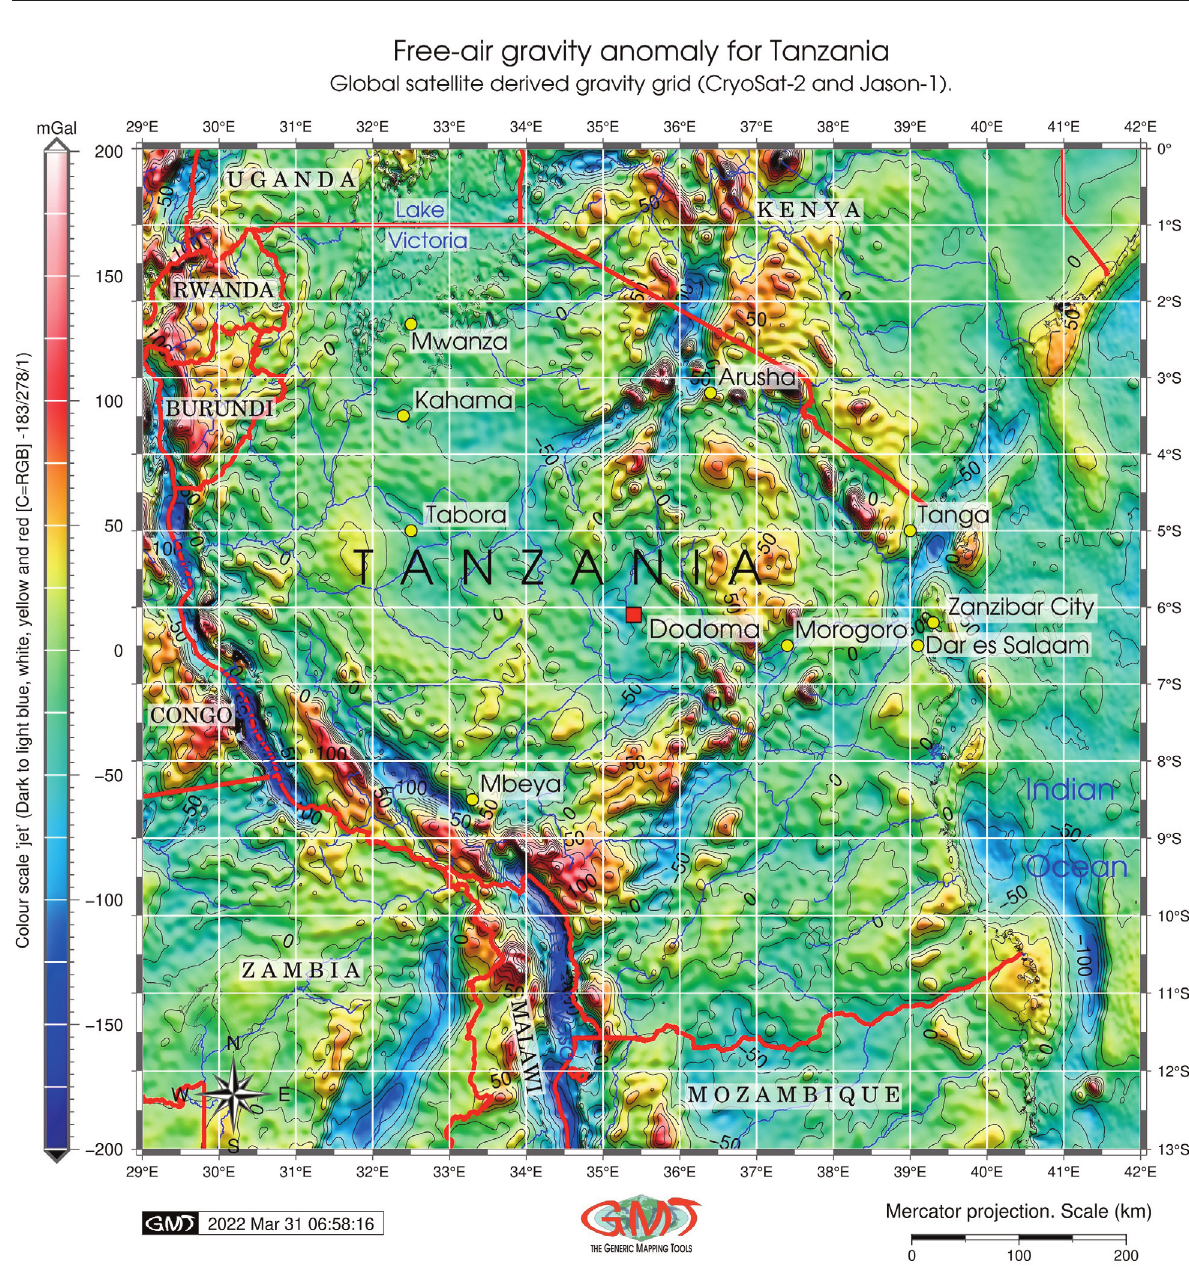
Fig. 5. Free-air gravity anomaly of Tanzania. Data source: CryoSat-2 and Jason-1. Map source: elaborated by the